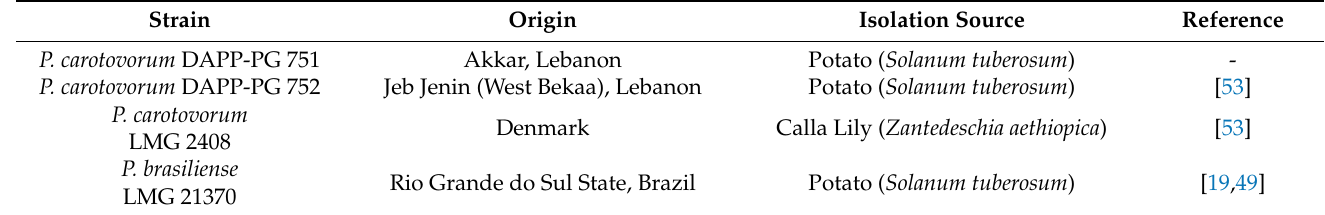
Table 2. P. carotovorum and P. brasiliense reference strains used in this study.